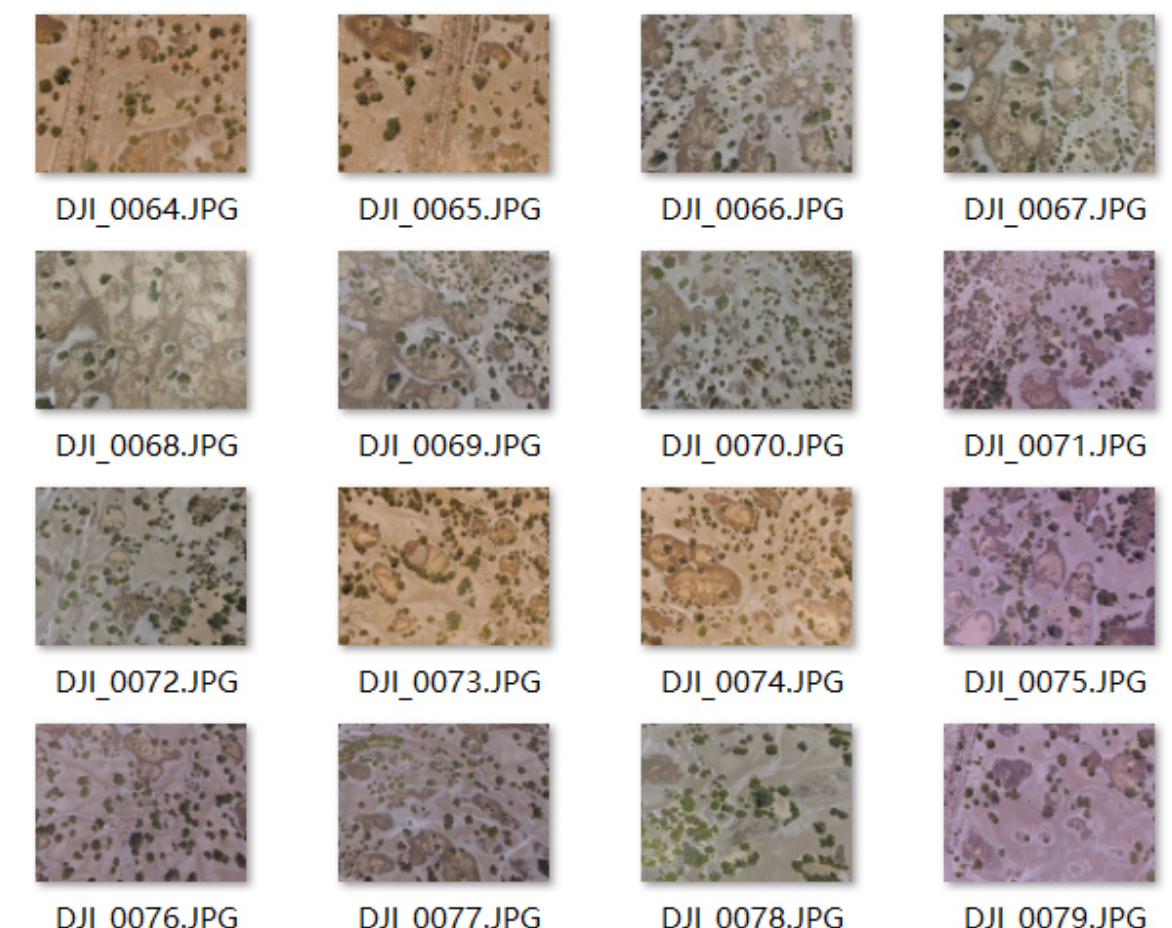
Figure A6. An example of a set of GRID photos with unnatural white balance in 2015.